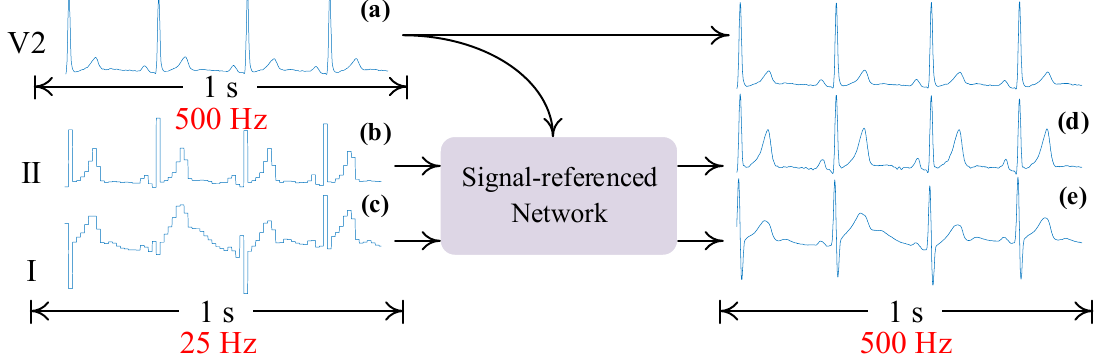
Figure 3. A schematic diagram of using the signal-referenced network to reconstruct signals. ( a ) is the high-sampling-rate signal. ( b , c ) are compressed signals. ( d , e ) are reconstructed signals.